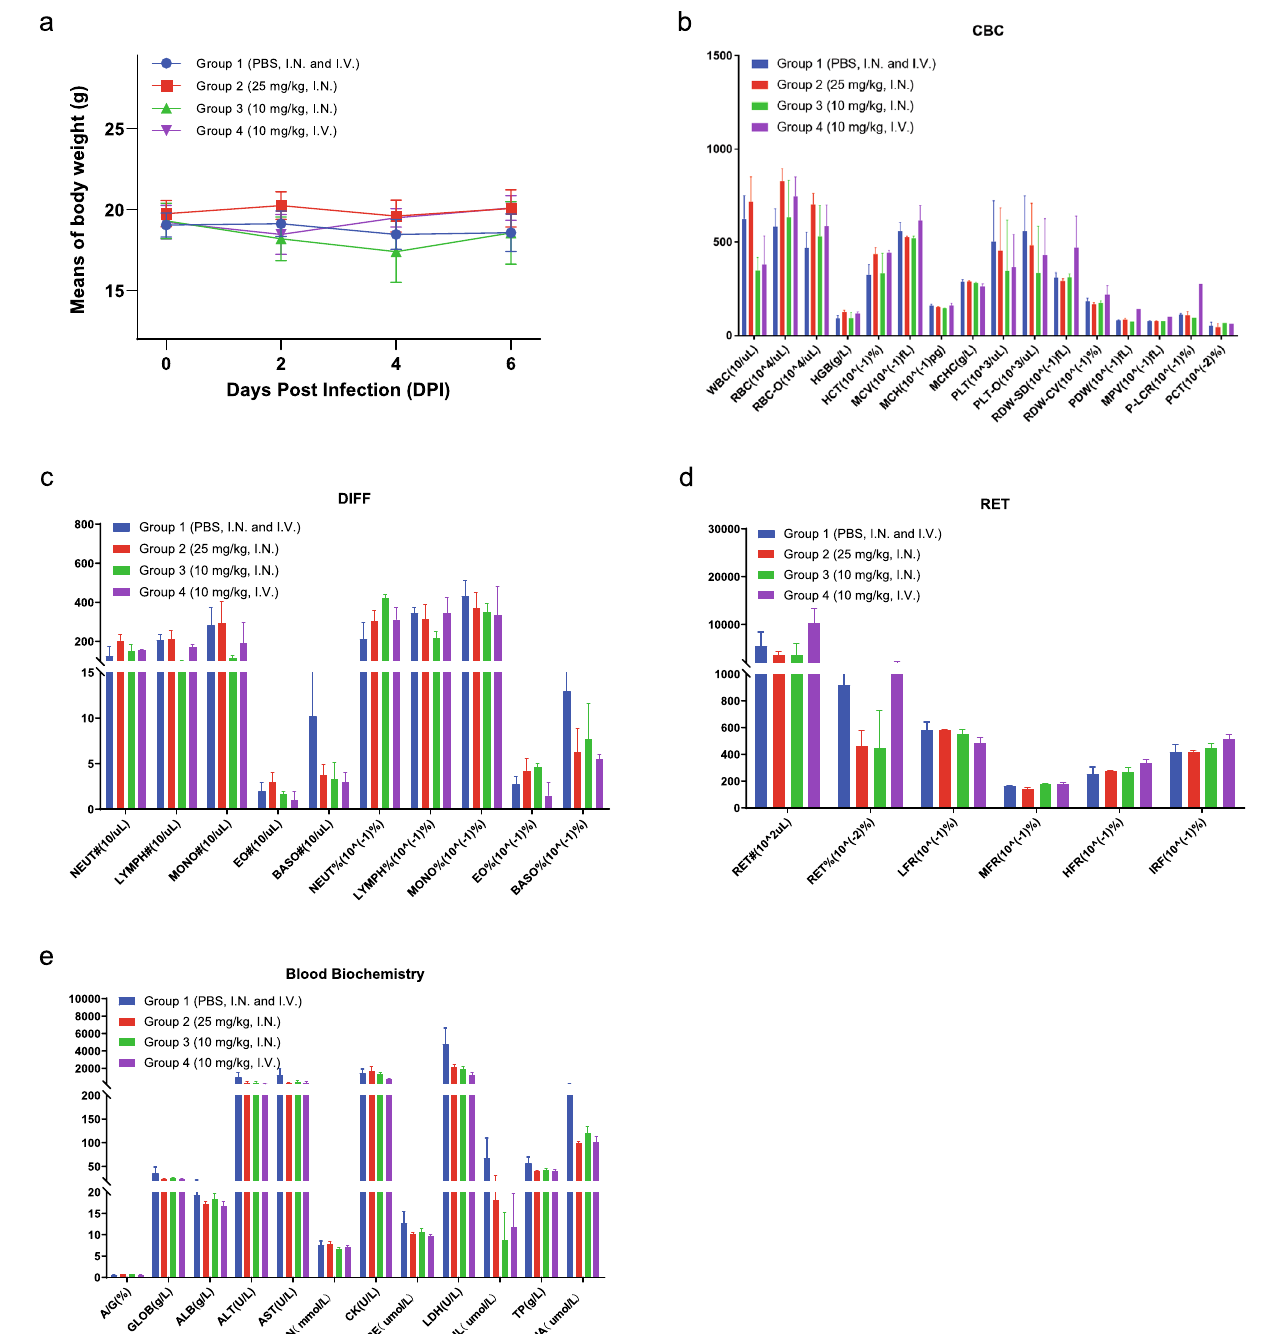
Figure 3. ABS-VIR-001 is safe in animals based on a blood biomarker assessment. M-NSG mice were divided into 4 treatment groups as indicated and observed for body weights until D6. Then, the mice were euthanized, and blood was collected for hematological and metabolic evaluation. Overall, based on all the blood parameters evaluated, no major differences in were observed between ABS-VIR-001 treated mice and PBS control treated mice, indicating that ABS-VIR-001 is safe. ( A ) The quantitation of the mouse bodyweights over time following antibody treatment, represented by mean body weight per treatment group. B) Complete blood count (CBC) panel. ( C ) Blood differential (DIFF) panel. ( D ) Reticulocyte (RET) count. ( E ) Blood biochemistry panel. The graph was generated using the Prism (GraphPad) software v9.2.0 (https:// www. graph pad.